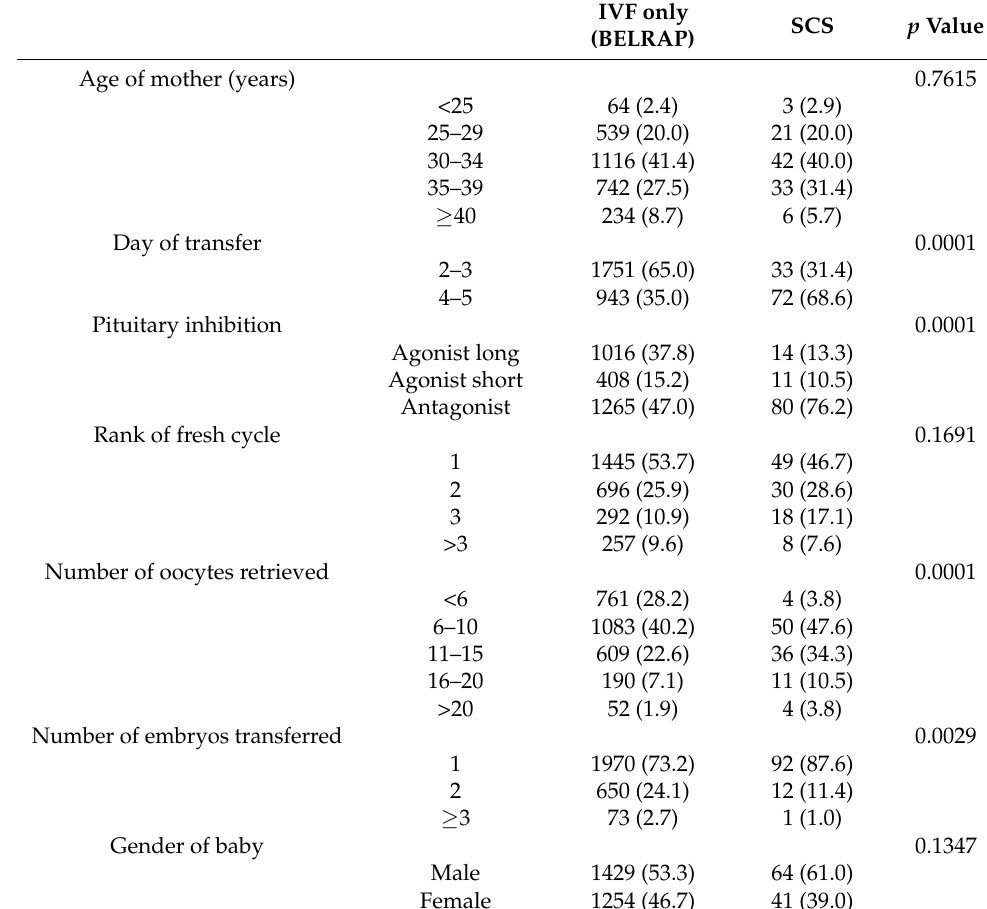
Table 5. Descriptive statistics of the risk factors for which the adjustment was performed—number (%) fresh ET